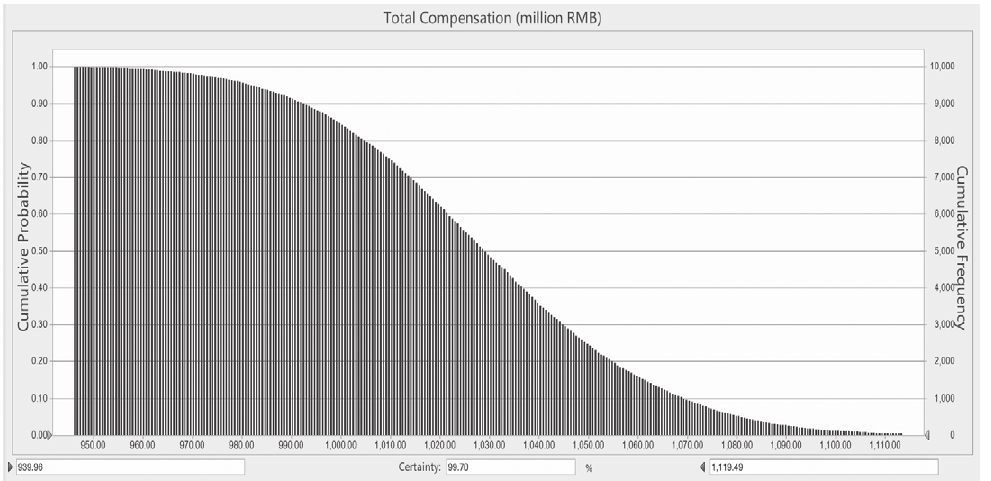
Figure 5. Cumulative probability distribution of total